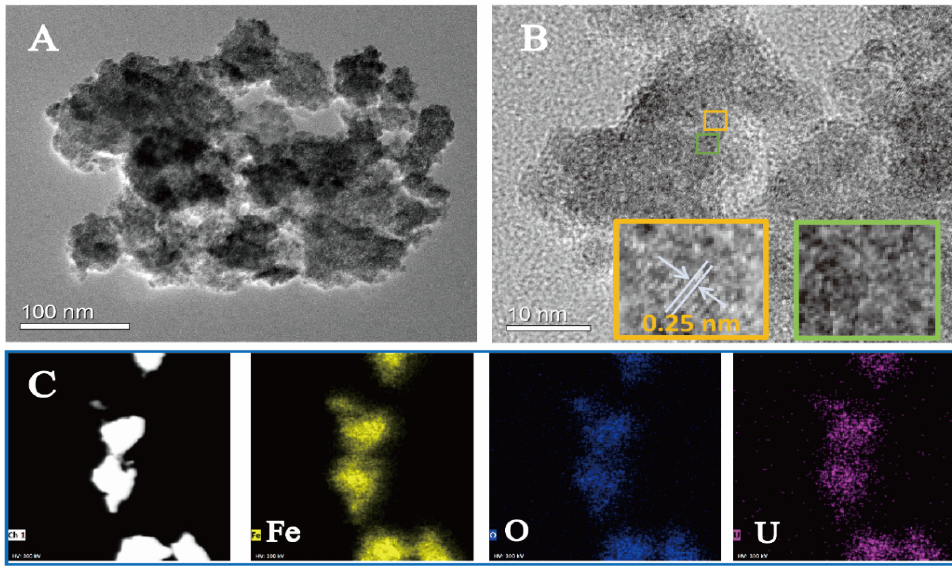
Figure 5. TEM images of ferrihydrite after the photocatalysis of U(VI) in air ( A , B ), and the corresponding element distribution ( C ).